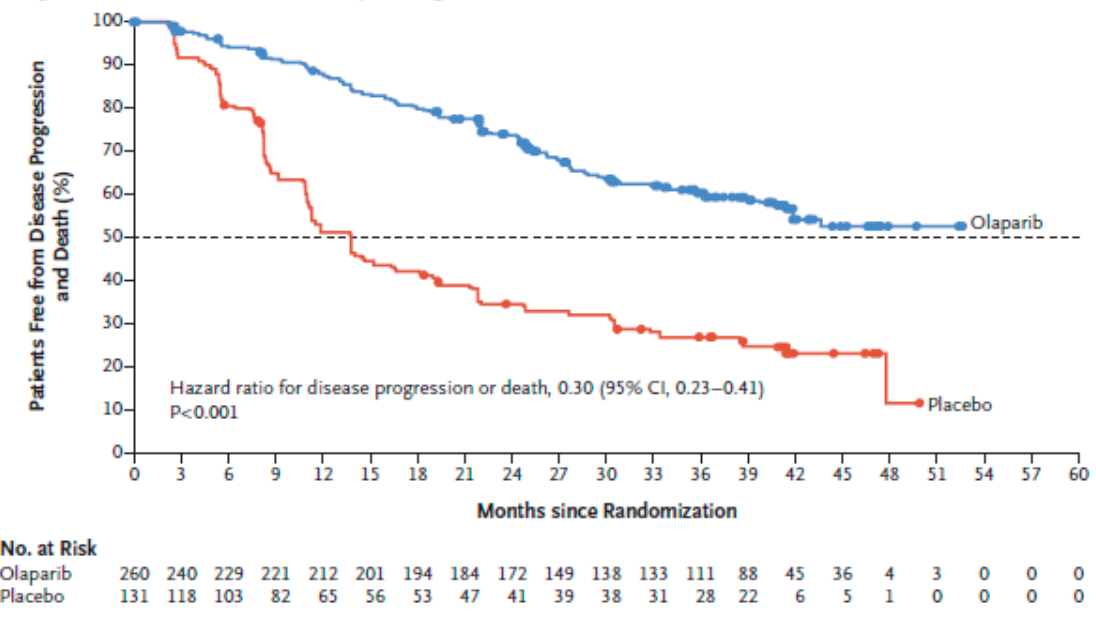
Figure 2. Kaplan–Meier estimates of the rate of freedom from disease progression, as assessed by investigators, and from death in the olaparib group and the placebo group of SOLO1 clinical trial.